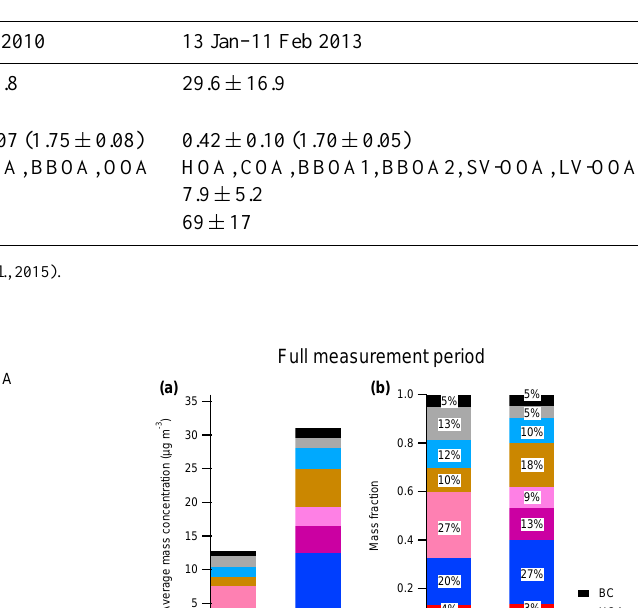
Table 3. Comparison of aerosol properties and meteorological parameters between the campaign in Fresno in winter 2010 and winter 2013.